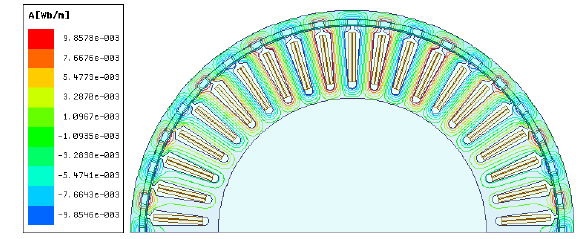
Figure 13. Flux lines distribution map of the brushless DC motor.